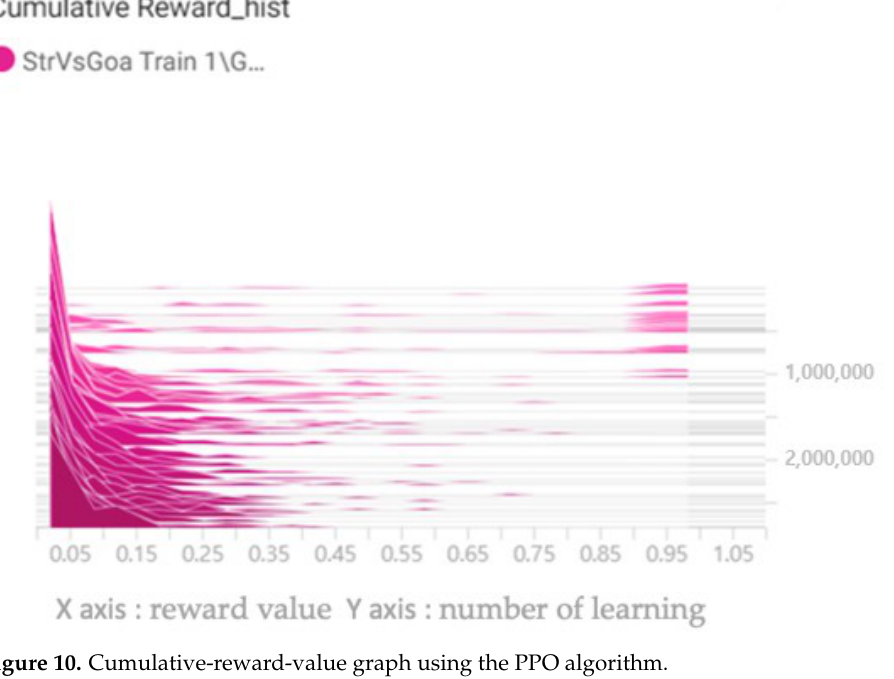
Figure 10. Cumulative-reward-value graph using the PPO algorithm.